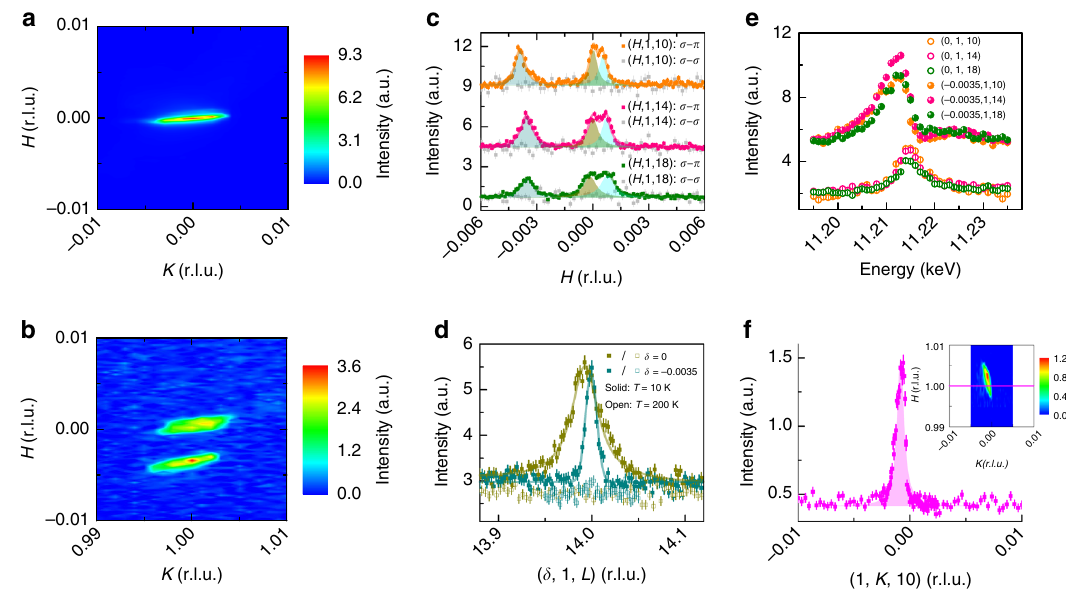
Fig. 3 REXS data from sample x = 0.04 collected at 6-ID-B. a , b H,K maps at the (0, 0, 16) and (0, 1, 14) zones at T = 10 K. c H scans at select (0, 1, 4 N + 2) ( N = 2, 3, 4) magnetic zone centers at 10 K collected both in the σ – π channel and the σ – σ channel. Solid lines are fi ts to the data with three Lorentzian peaks, which are individually represented by blue tan and cyan shaded areas. Data collected at different zones and in different channels are offset for comparison. d L scans at the commensurate (0, 1, 14) and incommensurate ( − 0.0035, 1, 14) positions at 10 K (solid symbols) and at 200 K (empty symbols). The solid lines are fi ts to the data with a single Lorentzian peak and the dashed line denotes the instrumental resolution. e Energy scans at the commensurate and incommensurate peak positions. Data are offset for clarity. f K scan at (1, 0, 10) at T = 10 K after the sample was rotated counter- clockwise by 90°. The inset shows the H,K map about the (1, 0, 10) position and the magenta line denotes the scan direction in the main panel. No splitting along K is observed, and additional analysis suggests a splitting still occurs along the H direction (Supplementary Figure 3(b – f)). Other than ( e ), all data are collected at the energy of 11.214 keV. All vertical error bars in the fi gure represent 1 s.d. statistical errors